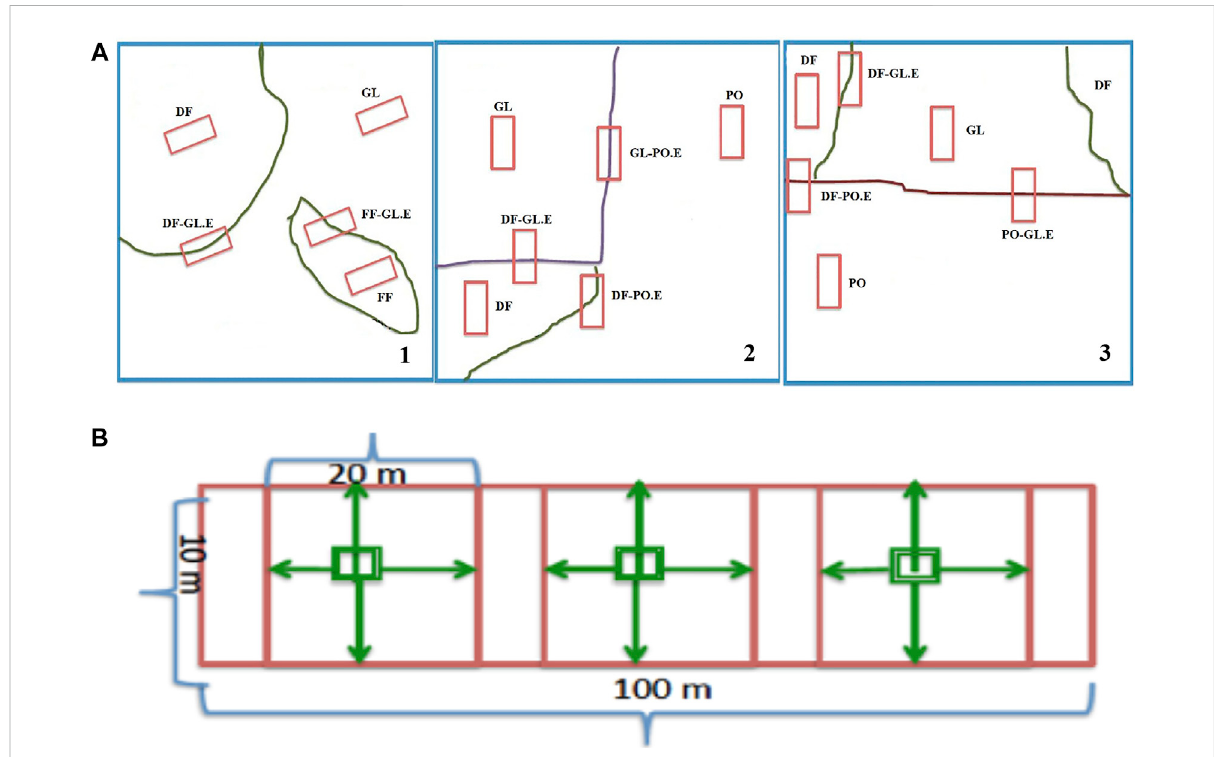
FIGURE 2 (A) Transects location within and between the landscape mosaic in the Orotoy river basin. Red squares represent transect within sampling area . 1) Upper window zone. 2) Middle window zone. 3) Lower window zone. FF, Fragmented Forest; DF, Tropical Dense Humid Forest; GL,